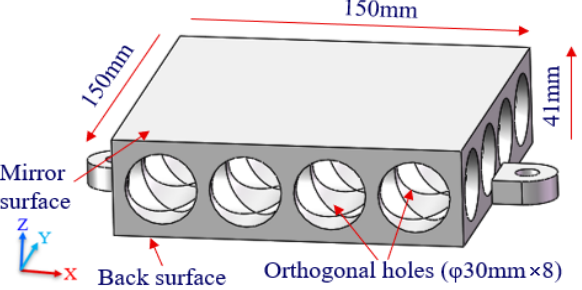
Figure 4 . The traditional mirror model with orthogonal holes array. Figure 4. The traditional mirror model with orthogonal holes